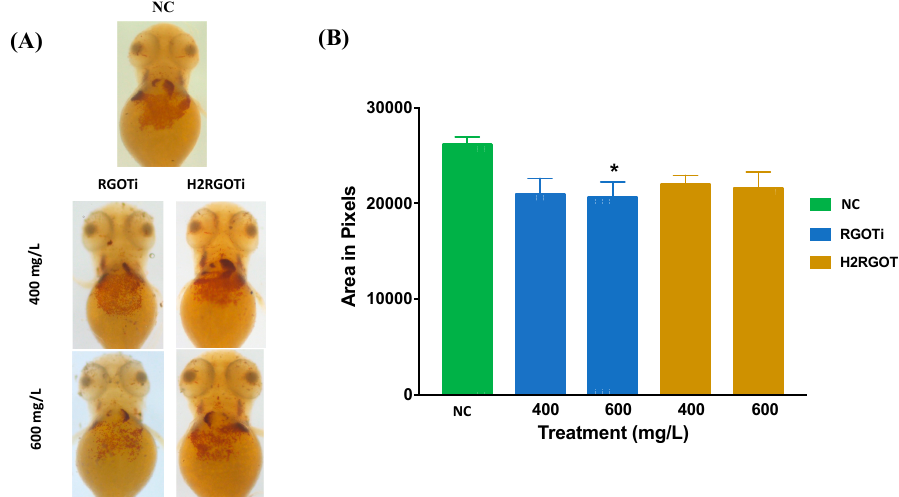
Figure 5. Distribution of haemoglobin- positive cells was detected by O-dianisidine staining at 72-hpf. ( A ) Representative images of O-dianisidine Stain concentrated on the yolk sac of the NC, RGOTi (400, 600 mg/L), and H 2 RGOTi (400, 600 mg/L). The images were captured using bright field microscopy, at 50 × . ( B ) Quantification analysis of the erythrocytes number in the areas stained by o-dianisidine. Embryos treated with RGOTi, 600 mg/L showed a significant decrease in the hematopoietic activity as compared to NC. One-way ANOVA was used followed by the Dunnet test to compare the difference between the treated groups. n = 20, * p < 0.05